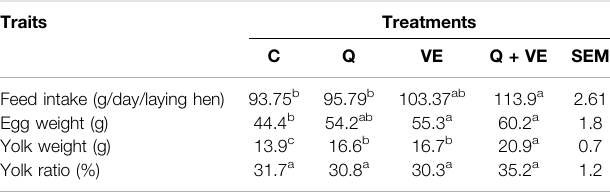
TABLE 3 | Effects of dietary Q, VE, and Q + VE on egg characteristics and yolk antioxidant status. Traits